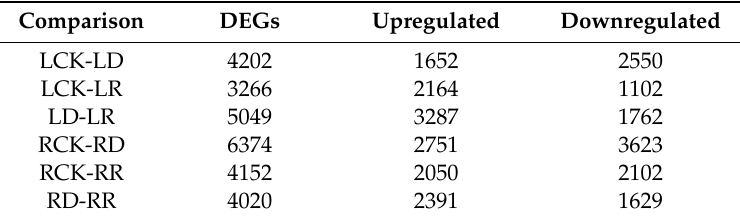
Table 2. Di ff erentially expressed genes (DEGs) under drought and re-watering treatments. Comparison